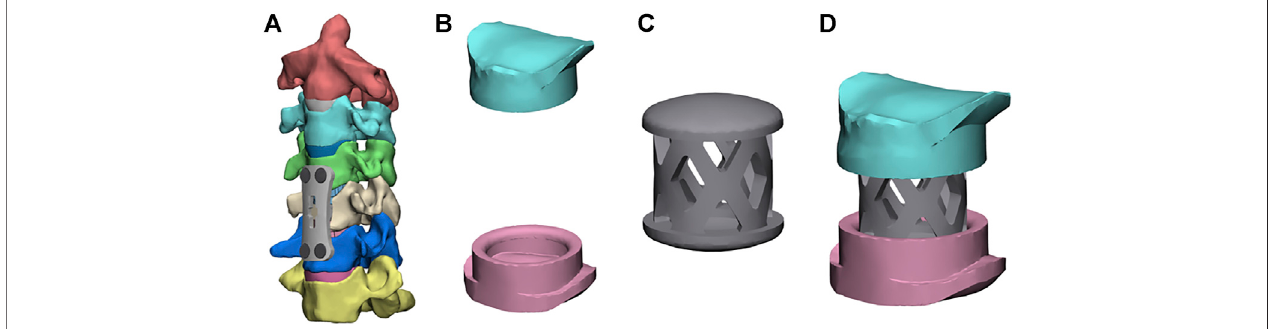
FIGURE 3 | Finite element models of the surgical procedures: (A) front view of ACCF using the NTMC, (B) the structure of spacers, (C) the structure of the TMC, and (D) TMC and the spacer are connected by the slot structure.